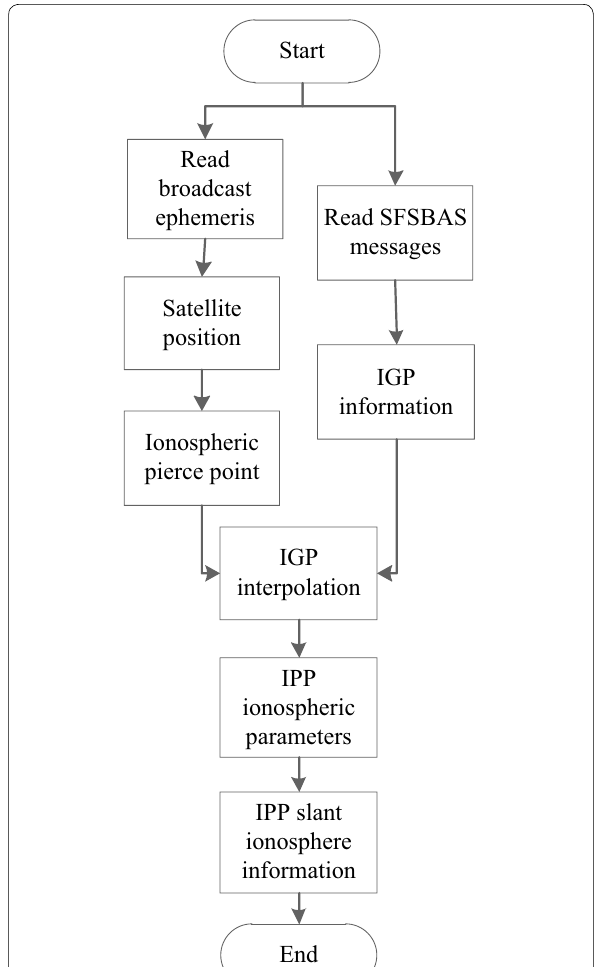
Fig. 11 Process of grid ionospheric correction method for single frequency SBAS users